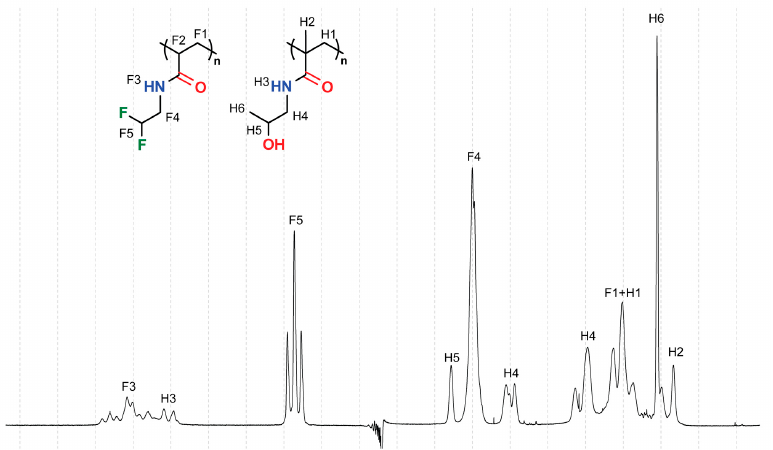
Figure 5. Spectral assignment of 1 H NMR spectrum (acquired at 25.0 °C) of the HF polymer sample.